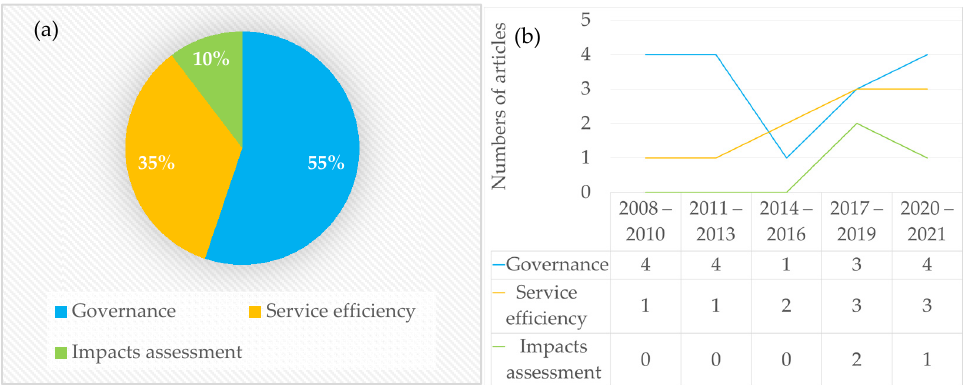
Figure 3. ( a ) Topic coverage IMC and water; ( b ) the evolution of the number of scientific articles IMC and water.